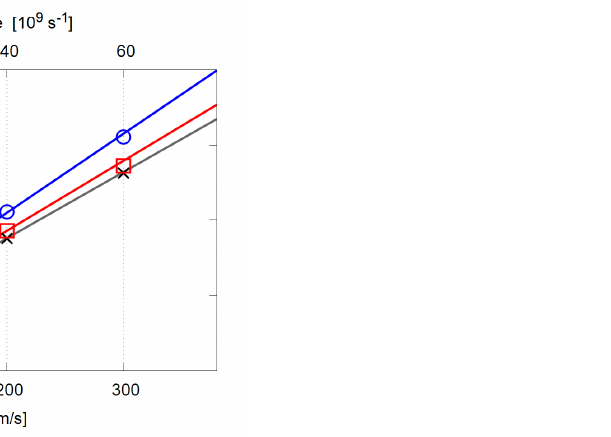
Figure 8. Time averaged shear stress (cid:104)− P xz (cid:105) plotted against the shear speed V x . The lines indicate the least square fitting to the linear relation, Equation (1), to evaluate the dynamic viscosity η .